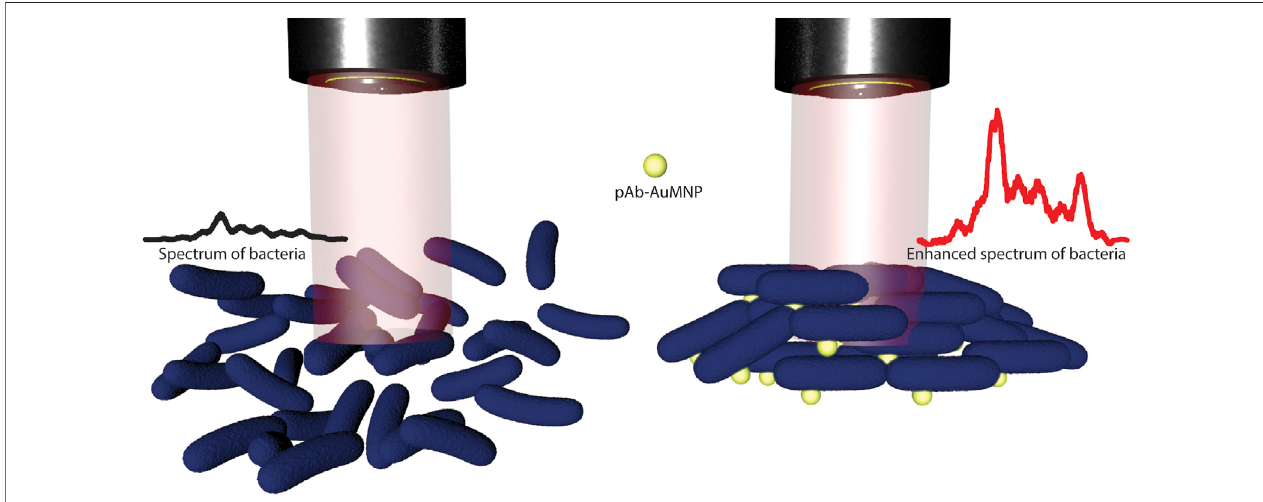
FIGURE 1 | Schematic illustration of label-free SERS method for bacteria detection using functionalized Au magnetic nanoshells (pAb-Lis-AuMNs). The scheme depicts amultilayerbacteria/pAb-Lis-AuMNs structure whichinduce anenhanced spectrumofthebacteria and afacile magneticseparationunderthe presenceofa35 Gauss magnetic fi